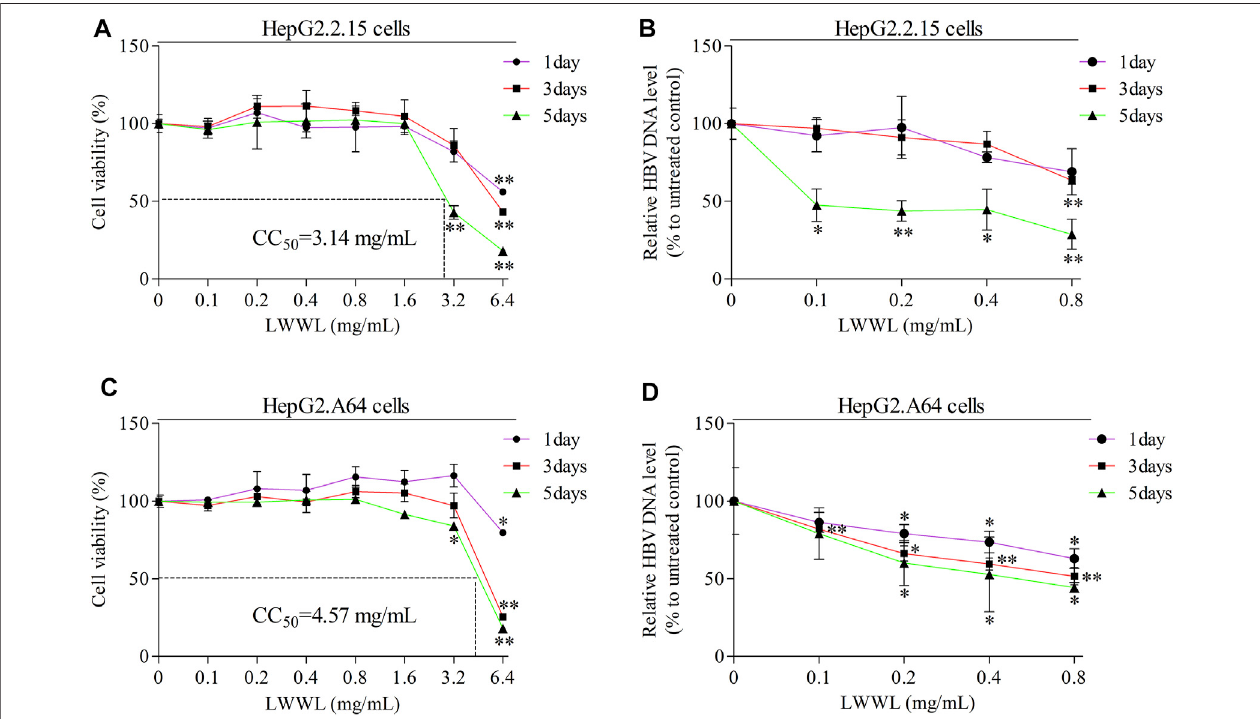
FIGURE 1 | Evaluation of safe concentration and optimal effective time of LWWL against HBV in cell models. The safe concentration of LWWL (de fi ned as that maintains ≥ 95%cellviabilitycomparedtodrug-untreatedcontrol)wererespectivelyevaluatedin (A) HepG2.2.15cellsand (C) HepG2.A64cells.Theoptimaleffectivetimeof LWWLagainstHBV(de fi nedastheday-pointwiththestrongestHBVDNAsuppressionduring5-daysobservation)wererespectivelyevaluatedin (B) HepG2.2.15cellsand (D) HepG2.A64 cells.Cellviability (A, C)and HBVDNAlevels(B, D)betweeneachofescalatedconcentrationsofLWWL-treated groupsand LWWL-untreatedgroup areanalyzed.*and**represent p < 0.05and p < 0.01respectivelyindifferencecomparisonbetweenresultant values treated witheachindicatedLWWLconcentrationand the value treated with zero LWWL concentration using Student ’ s t -test. LWWL, Liuweiwuling Tablet; CC 50 , the median cytotoxic concentration against cultured